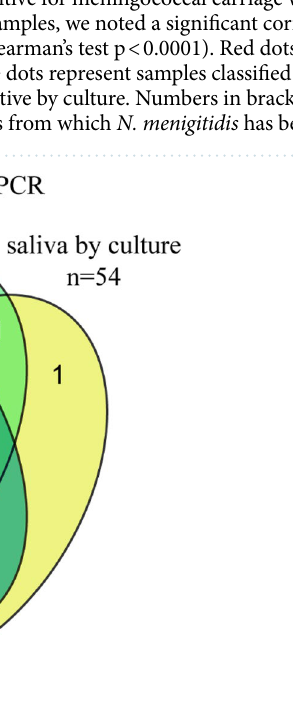
Figure 3. Venn diagram displaying the number of oropharyngeal and saliva samples positive for meningococci based on recovery of live N. meningitidis strain from a culture (samples positive by culture, includes qPCR- guided culturing) or when tested with